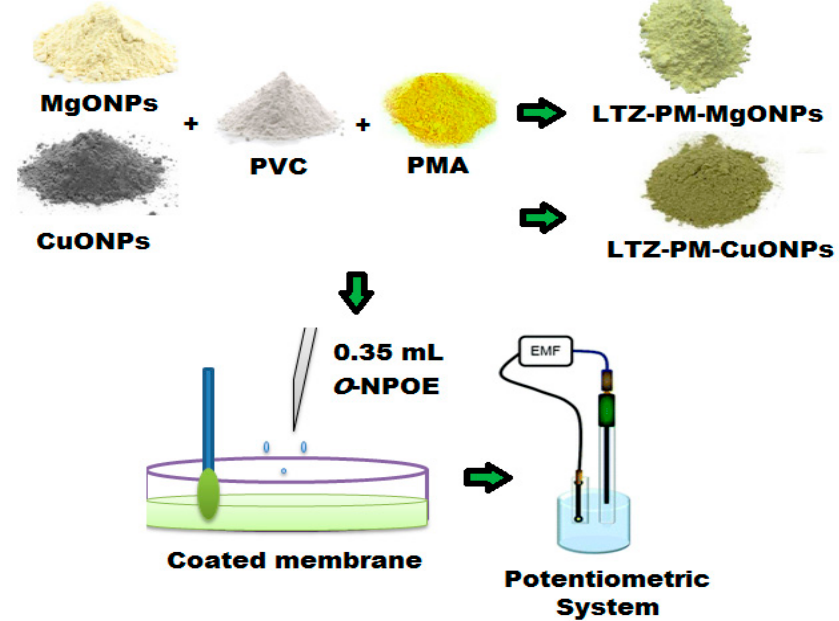
Figure 1. Illustrated the construction of the modified sensor and its potentiometric